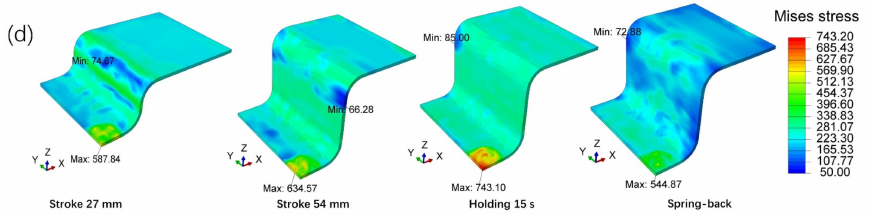
Figure 25. ( a ) Temperature; ( b ) Thickness; ( c ) Strain; ( d ) Stress with TPP-F. The minimum thickness measured on the wall is about 1.91–1.92 mm, with a thinning rate of about 4.5%. There is no risk of rupture in this region. The flange edge contact with the binder and the bottom contact with the punch are slightly thickened to 2–2.02 mm due to radial and circumferential stress. Figure 26 points out that the numerical simulation is in good agreement with the experimental results.